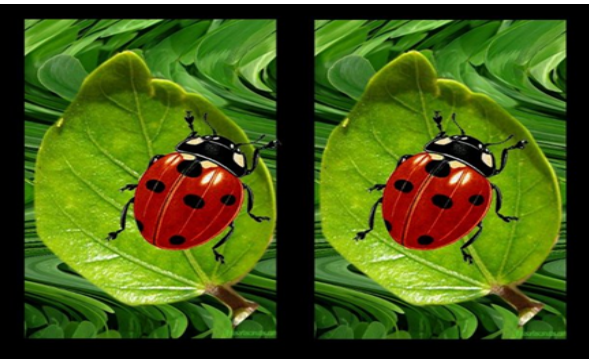
Figure 5. 3D/Stereoscopic Image or Stereo